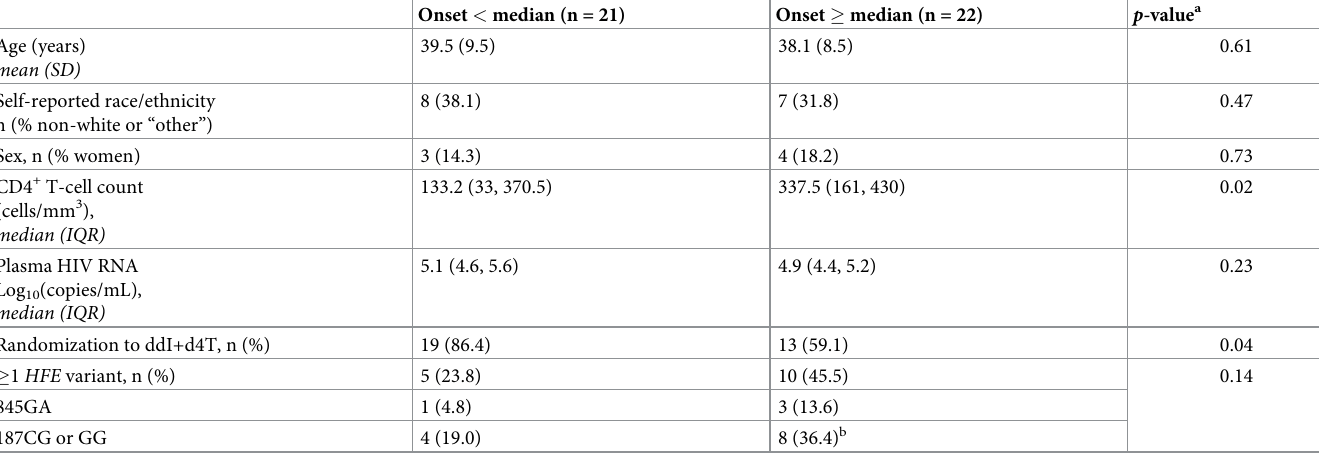
Median onset of peripheral neuropathy overall was 259 days (398 days for carriers of HFE variant alleles, and 252 days for those with ancestral HFE alleles). More neuropathy cases than controls were randomized to the didanosine (ddI) arm and CD4+ T-cell counts were higher in individuals with slower onset. The proportion of participants with � 1 HFE gene variant was nonsignificantly higher in the group with delayed-onset neuropathy. a Equality of medians test was used for comparison of variables that were not normally distributed; Student’s t -test for normally distributed variables; Chi-squared tests for between-group comparison of categorical variables. Two-tailed p -values < 0.05 are considered significant. b One person was a compound heterozygote with both 845A and 187G alleles and is therefore included in both genotype